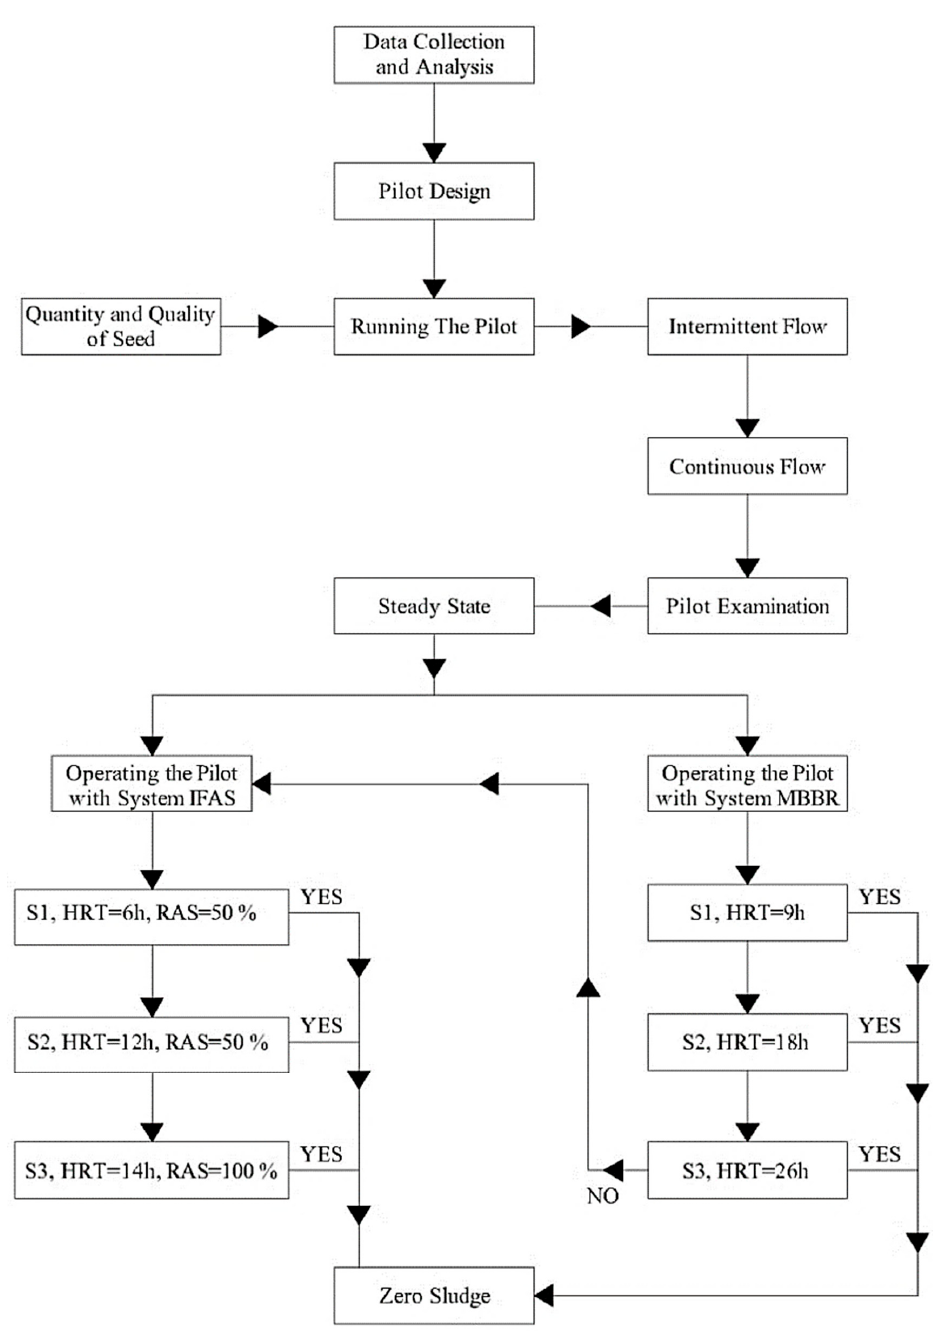
Figure 2. Flow diagram of operational procedure.